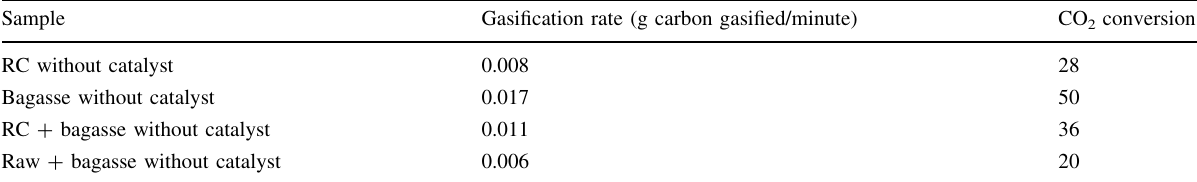
Table 6 Carbon conversion (Gasification rate) and CO 2 conversion during CO 2 gasification